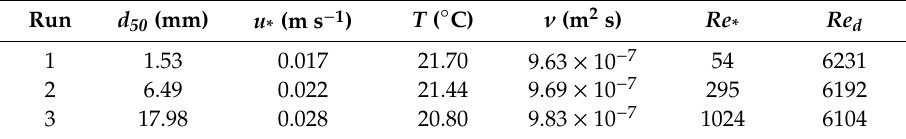
Table 1. Details of the experimental conditions.